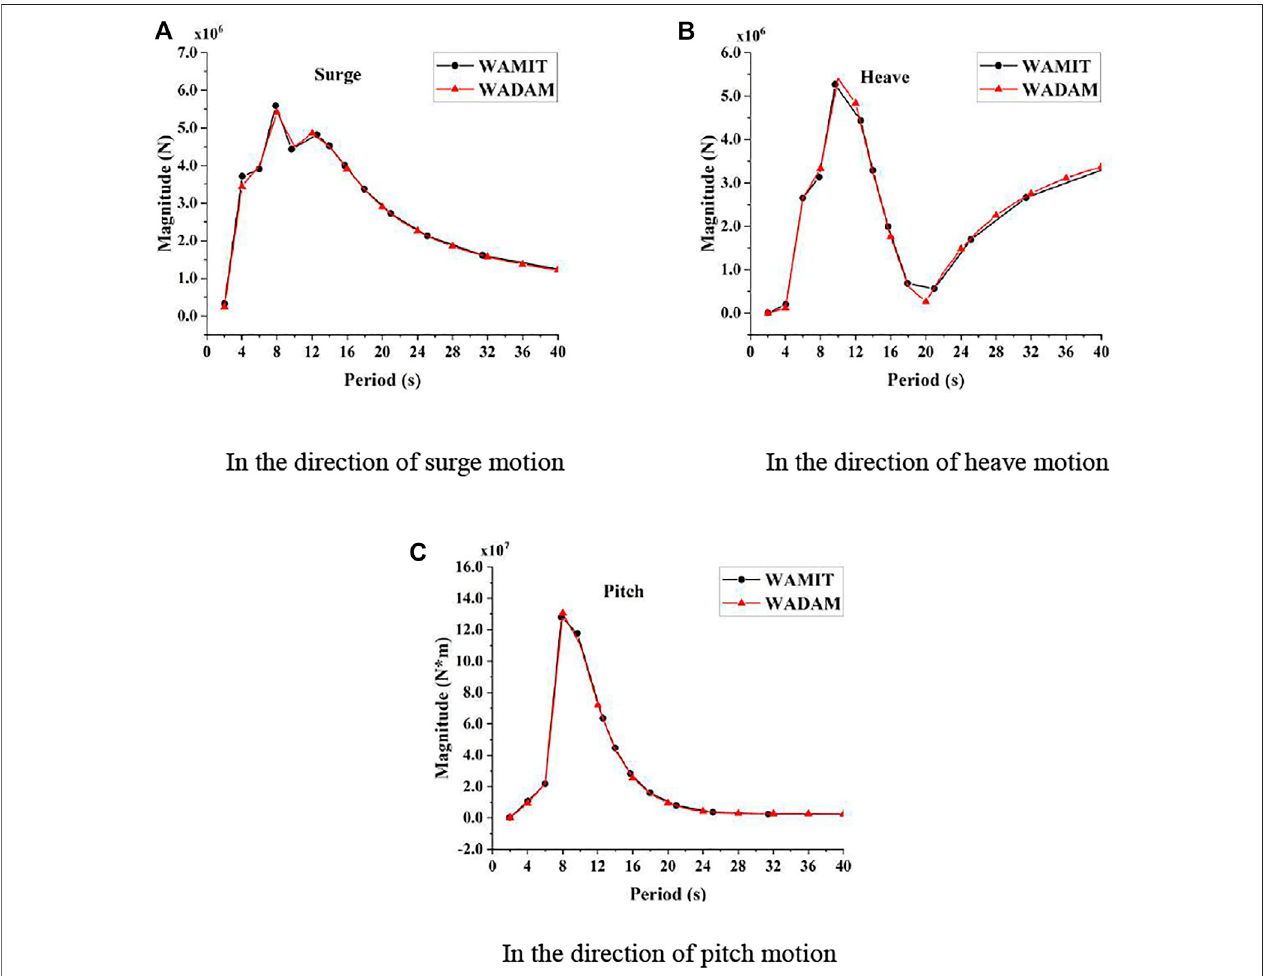
FIGURE 5 | Magnitude of the force in the direction of (A) surge motion, (B) heave motion, and (C) pitch motion of the FOWT.